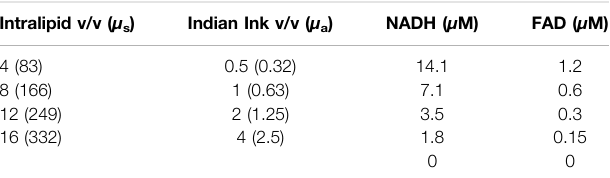
TABLE3| Concentrationsofallliquidphantomcomponentsincluding μ s and μ a of intralipid and Indian ink, respectively. Intralipid v/v ( μ s